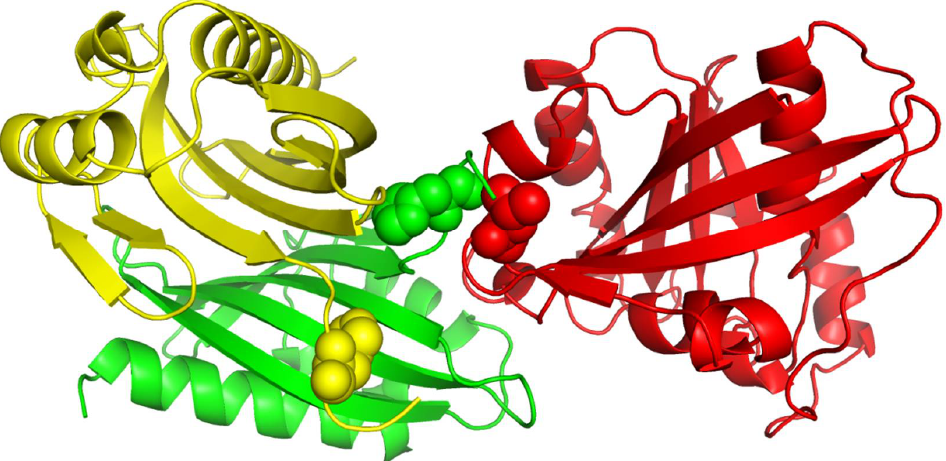
Figure 8. The 3D structure of protein complex 1A2K. The A, B, and C chains are colored in yellow, green, and red, respectively. The green and red balls indicate part of the interaction interface within 1A2K. The yellow balls share the same sequence configuration as the green balls, but they do not interact with the red balls.